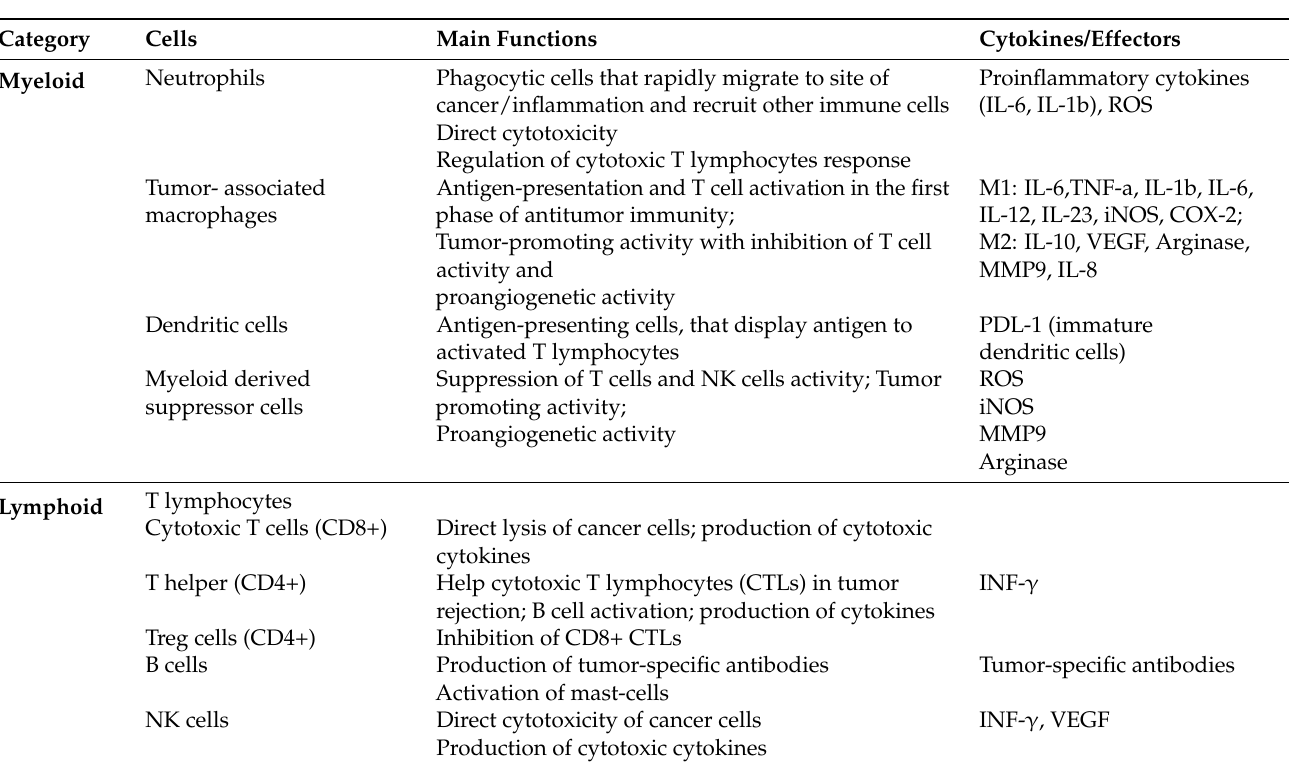
Table 1. Definition of the main immune cells involved in cancer-related inflammation and paraneo- plastic leukocytosis and their respective